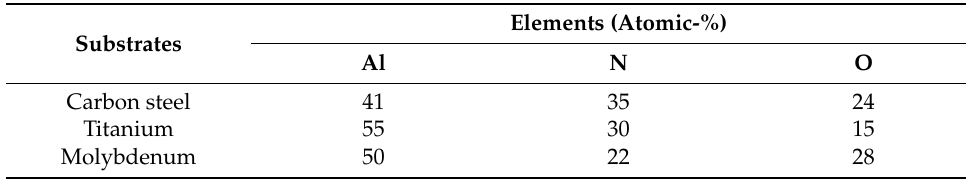
Table 5. A summary of the atomic percentage of each element in coatings sprayed on carbon steel, Ti and Mo substrates as calculated by